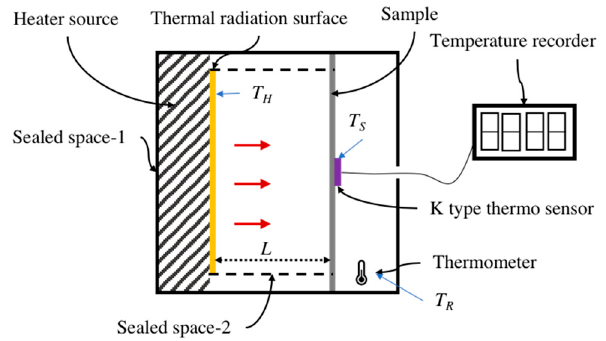
/ Ni-coated Milife fabric.